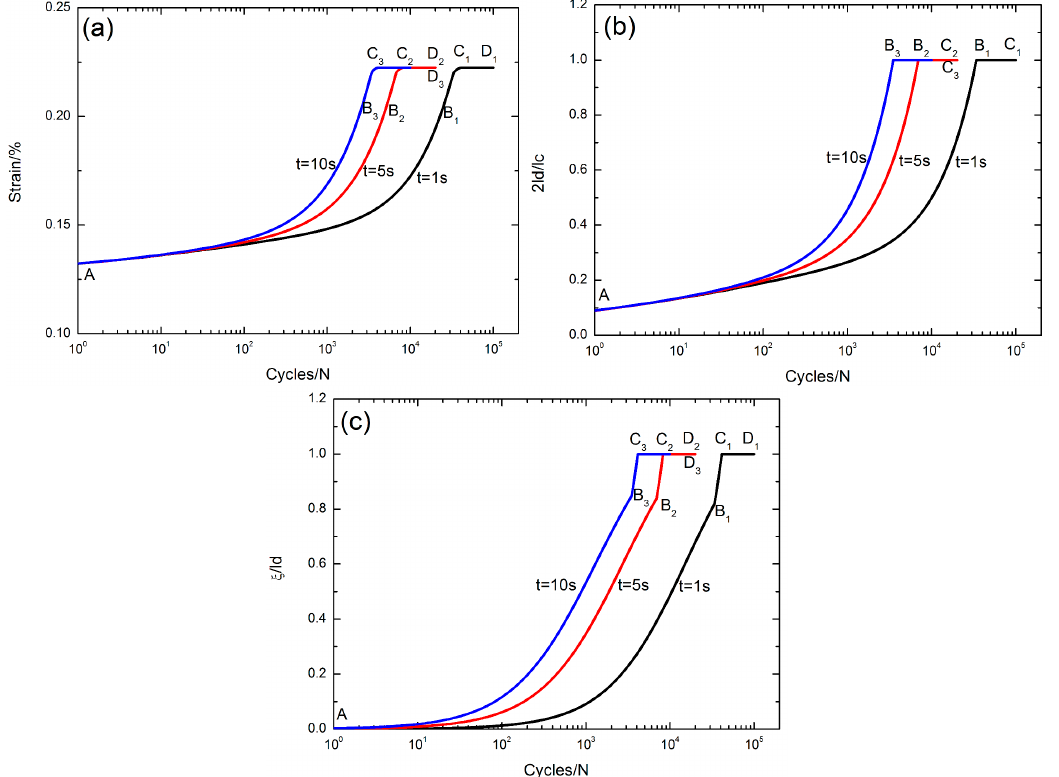
Figure 6. ( a ) The peak strain versus cycle number curves; ( b ) the interface debonded length 2 l d / l c versus cycle number curves; and ( c ) the interface oxidation length ξ / l d versus cycle number curves under σ max = 200 MPa corresponding to different stress rupture times t = 1, 5 and 10 s at the oxidation temperature of Tem = 800 °C.